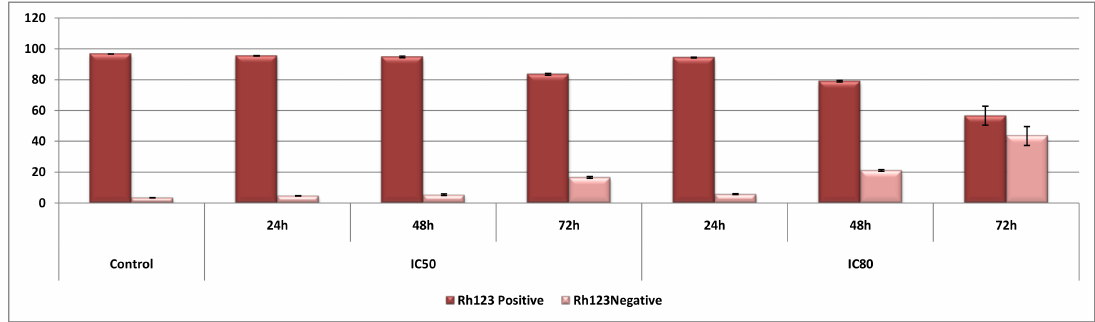
Figure 5. Percentage of HepG2 Rh123-positive cells, relative to untreated control cells (control), after treatment with OADP for 24, 48, and 72 h, at the IC 50 and IC 80 concentrations. Values are expressed as the mean SD of two independent experiments, performed in ±